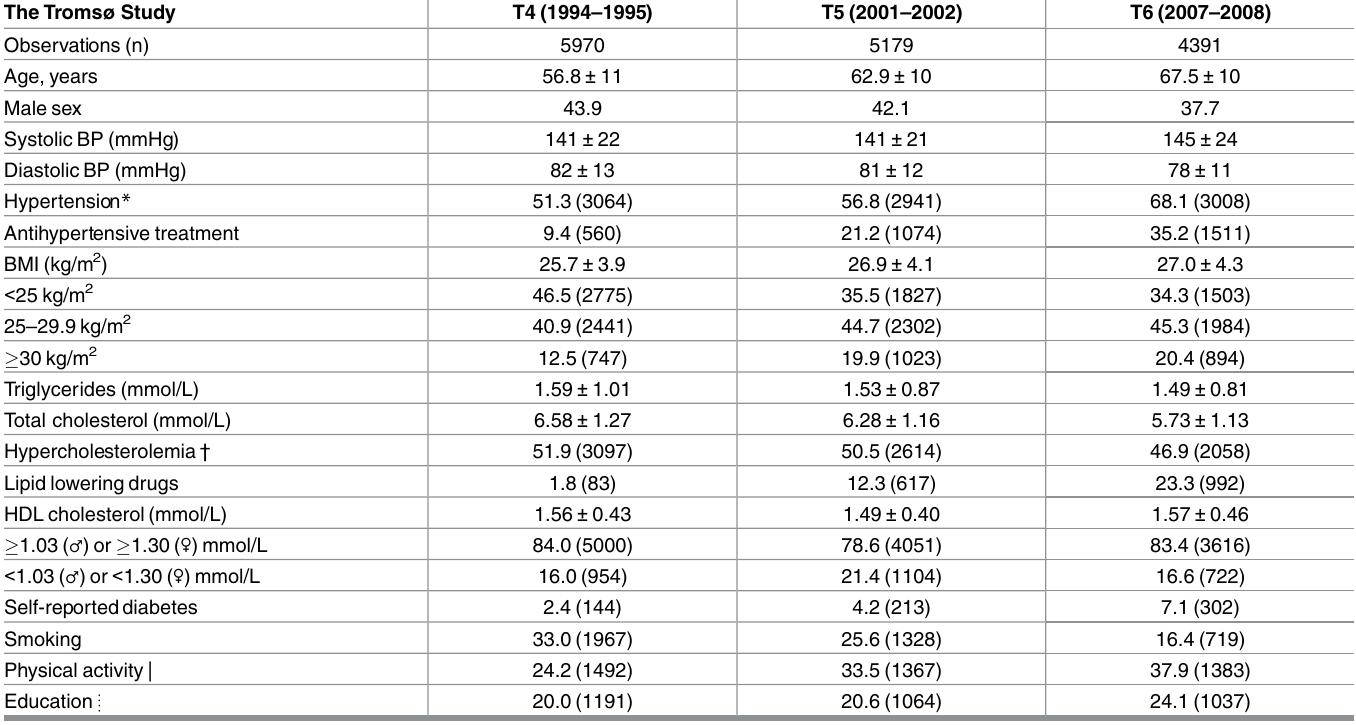
Table 1. Distribution of traditional atherosclerotic risk factorsin the different surveys. In total 5970 were includedin the study in 1994/95,and of these, 5179 and 4391 were re-measured in the 2001–02and 2007–08,